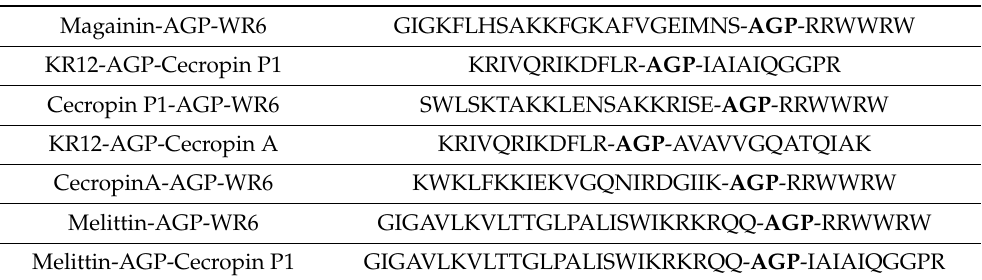
Table 2. Proposed AMPs based on amphipathic helix-AGP-hydrophobic